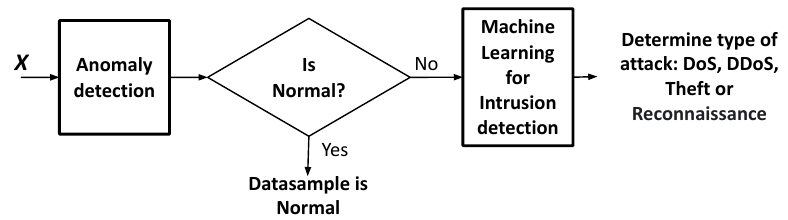
Figure 1. General